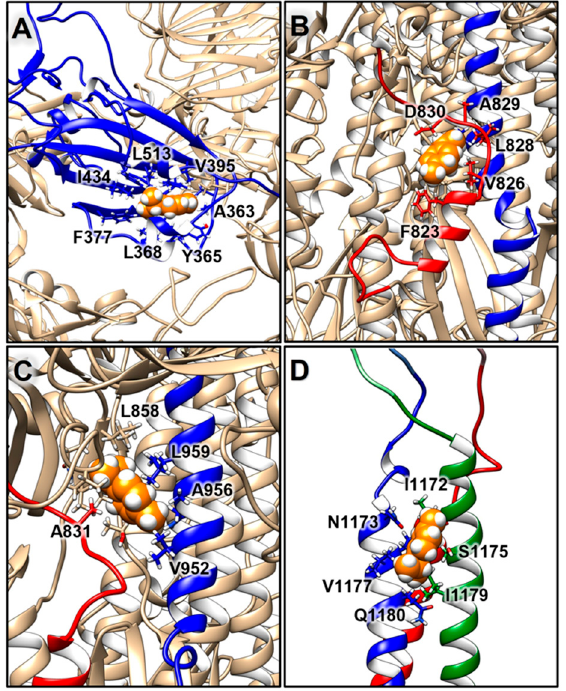
Figure 4. Binding locations observed for γ -terpinene, shown as spheres in orange, on different functional domains of S: ( A ) the RBD, in blue; ( B , C ) the S2 ′/ FP and HR1 regions, in red and blue, respectively; ( D ) the HR2 helix bundle, in blue, red, and green. Residues contacted by the ligands are shown as sticks.